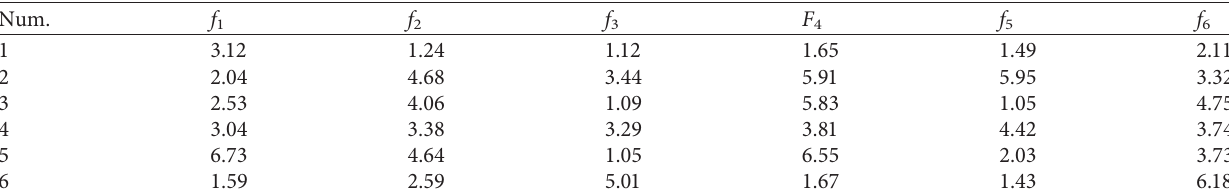
Table 17: 6 optimal routes of each part of total cost.